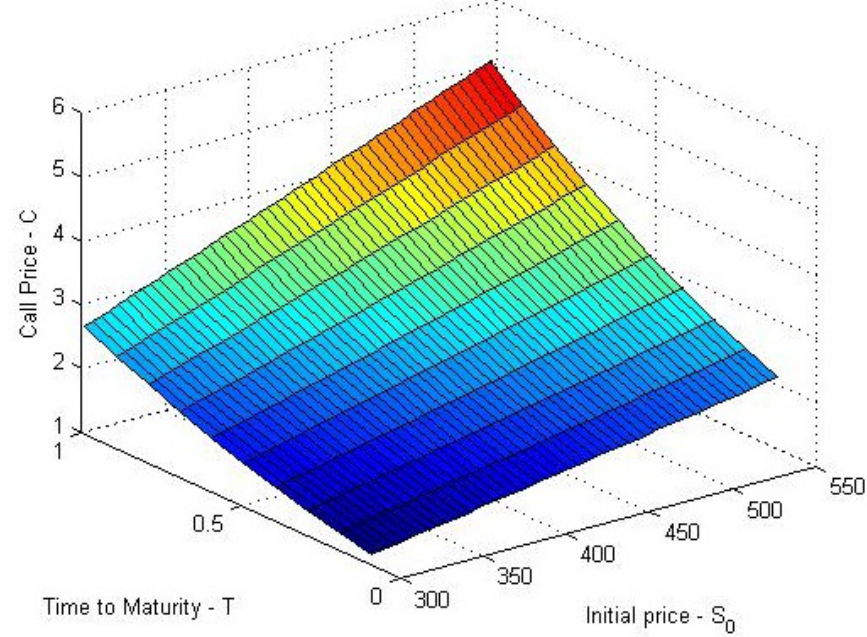
Figure 4. Up-And-Out call with CGMY( C = 0 . 0244 , G = 0 . 0765 , M = 7 . 5515 , Y = 1 . 2945 ) with Stock Price S 0 = 450, Strike price K = 150, Barrier B = 350, σ = 0.1812, r = 0.167 and Time to maturity T =